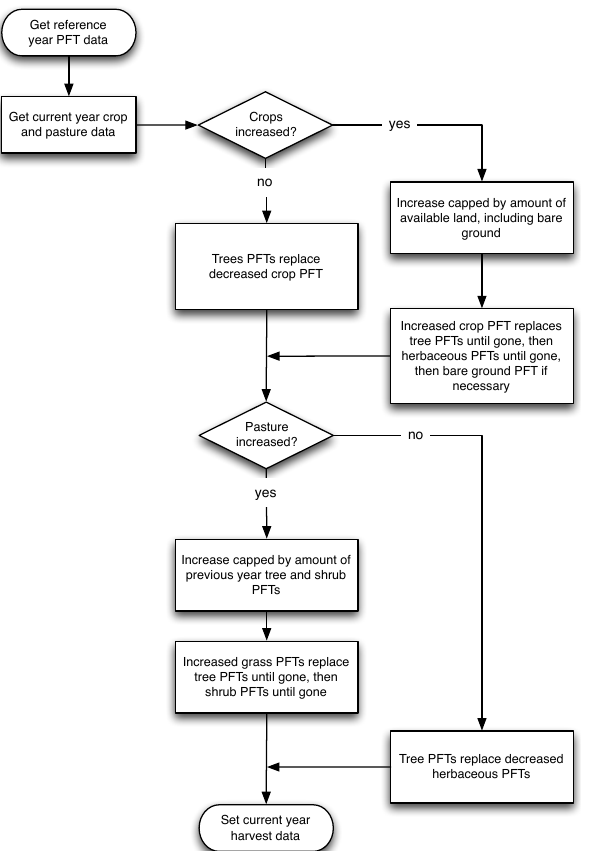
Figure 4. NEWLUT algorithm for dynamic PFT coverage. When cropland and pasture decrease, tree PFTs are added in proportion to potential vegetation fractions. When cropland and pasture increase, tree PFTs are removed first, then other non-crop PFTs, in proportion to reference year